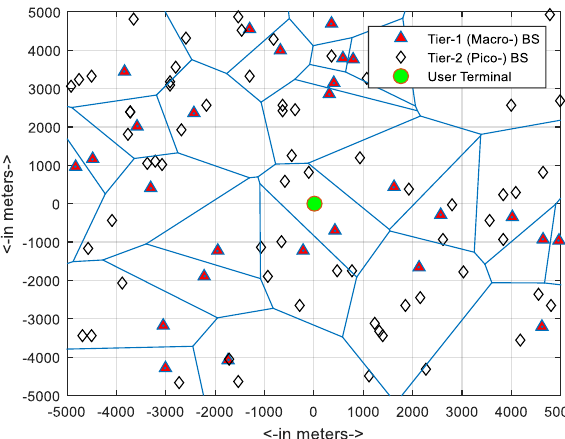
Figure 2. Topology of a simulated two-tier typical network. Table 1. Range of values of all input parameters used in the simulation.